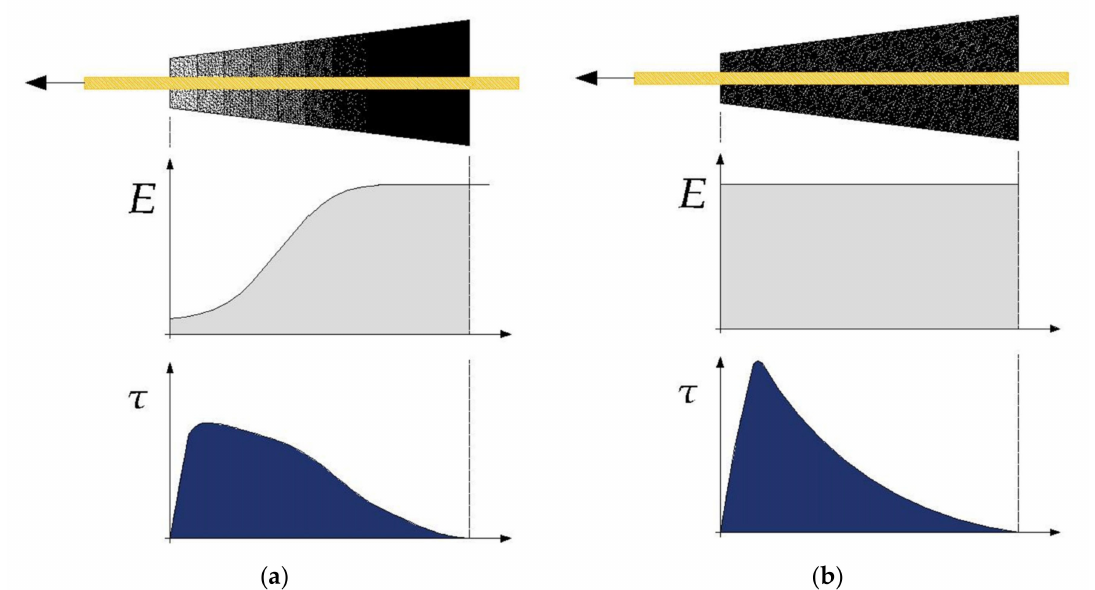
Figure 6. Bonded anchorages with ( a ) and without ( b ) gradient material: distribution of modulus of elasticity ( E ) and shear stress ( τ ) at the interface cable-potting